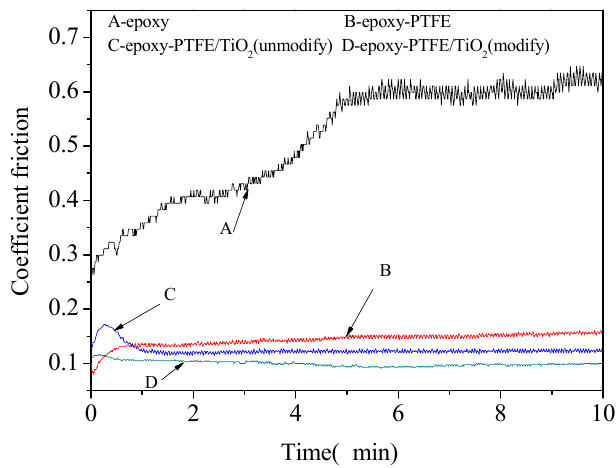
Figure 6. Friction coefficients of different coatings.